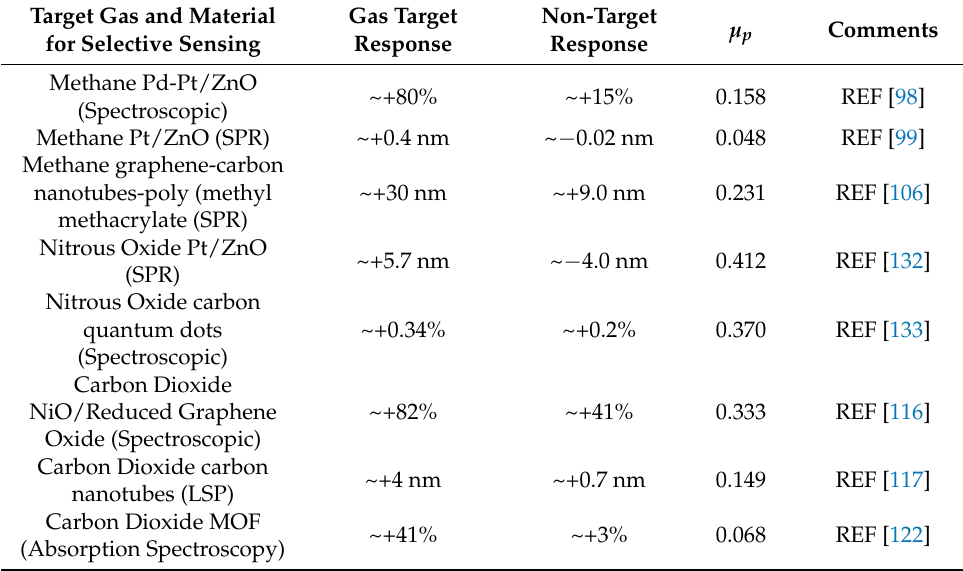
Table 5. Summary of chemical selectivity of various optical fibre